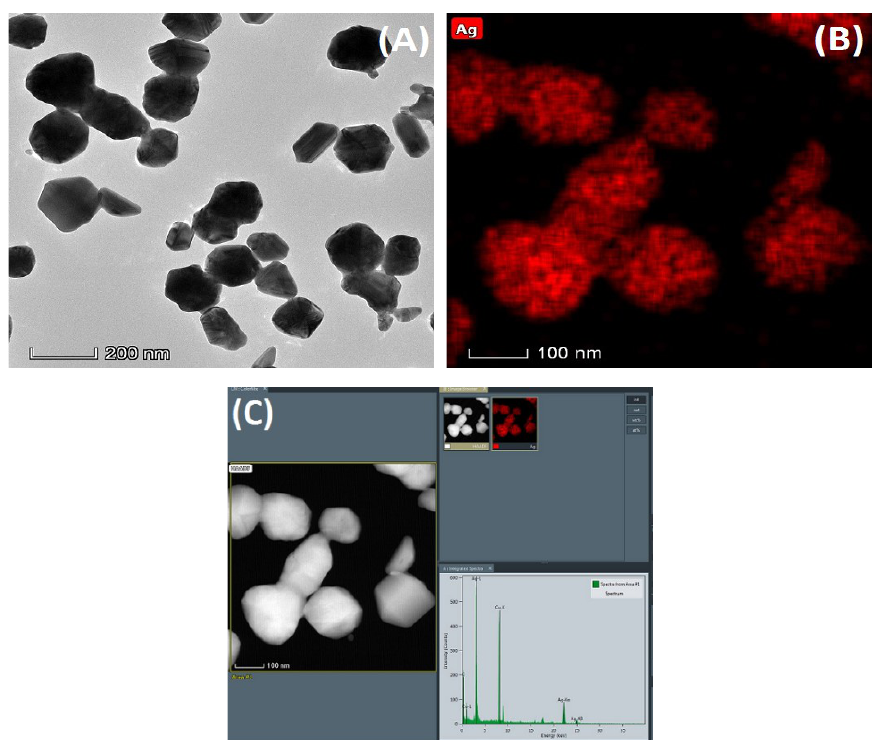
Figure 3. Morphological observation and elemental analysis of AgCl NPs by transmission electron